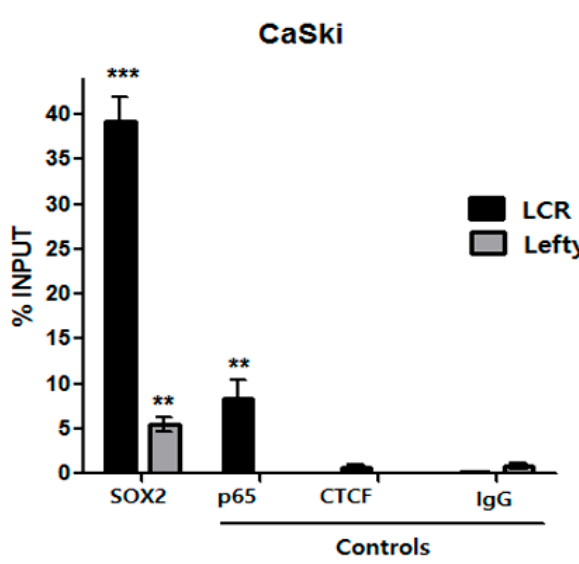
Figure 4. SOX2 binds to HPV16-LCR putative binding sites in vivo. Chromatin immunoprecipitation assay (ChIP) of SOX2 were performed evaluating the HPV16-LCR region (LCR) from CaSki cells. Anti-p65 and -CTCF antibodies were employed as positive and negative controls, respectively. Non-specific IgG antibody was included as a negative control. Quantitative PCR (qPCR) analysis was performed on the DNA obtained from the ChIP assay evaluating the HPV16-LCR region (black bars), and the Lefty (gray bars) gene promoter region, as a positive control of SOX2 binding ( n = 2). The graphic represents the percentage of input recovered after immunoprecipitation with anti-SOX2, -p65 or -CTCF antibodies. Three independent biological experiments were performed. The standard error of the mean of triplicate qPCR measurements is shown. ** p < 0.01, *** p < 0.001.